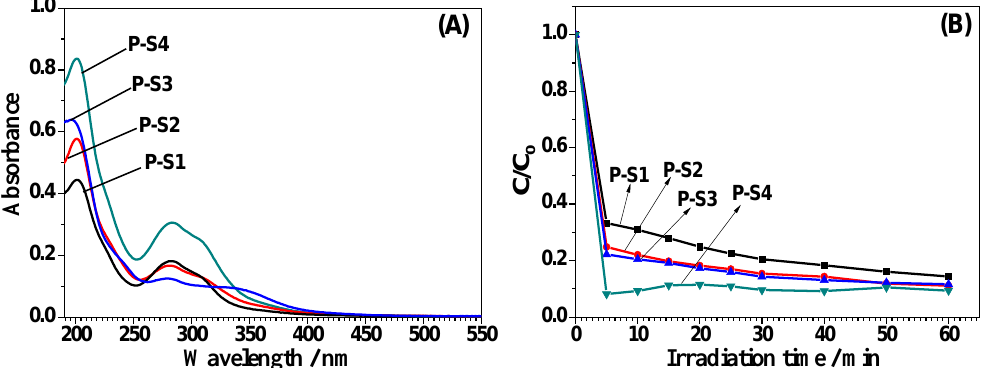
Figure 7. ( A ) UV-vis spectra and ( B ) photocatalytic degradation of MB under UV irradiation of bamboo charcoal-based composites precursors of P-S1, P-S2, P-S3, and P-S4.